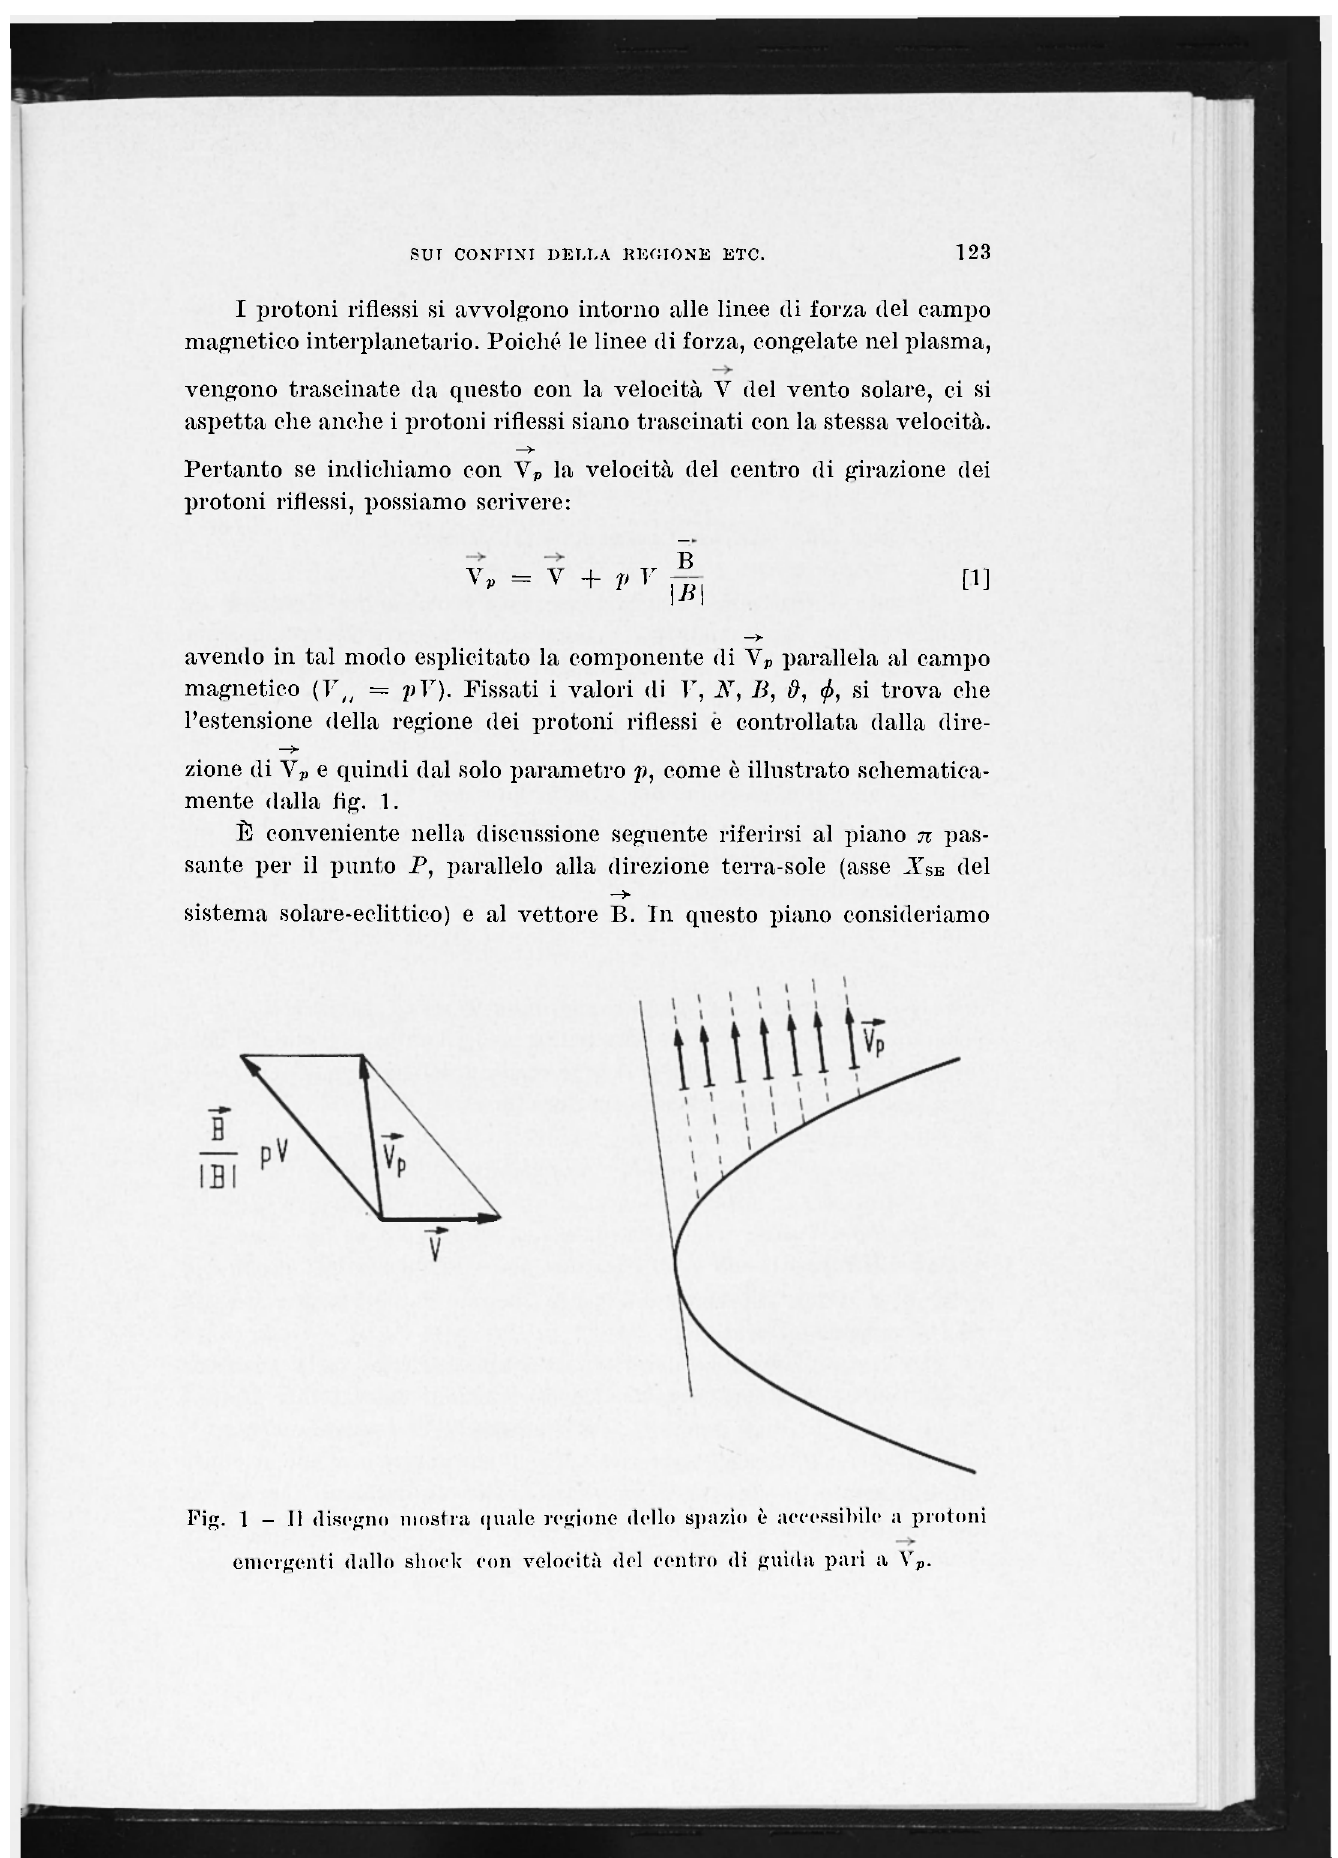
Fig. 1 II disegno mostra quale regione dello spazio è accessibile a protoni emergenti dallo shock con velocità del centro di guida pari a V p